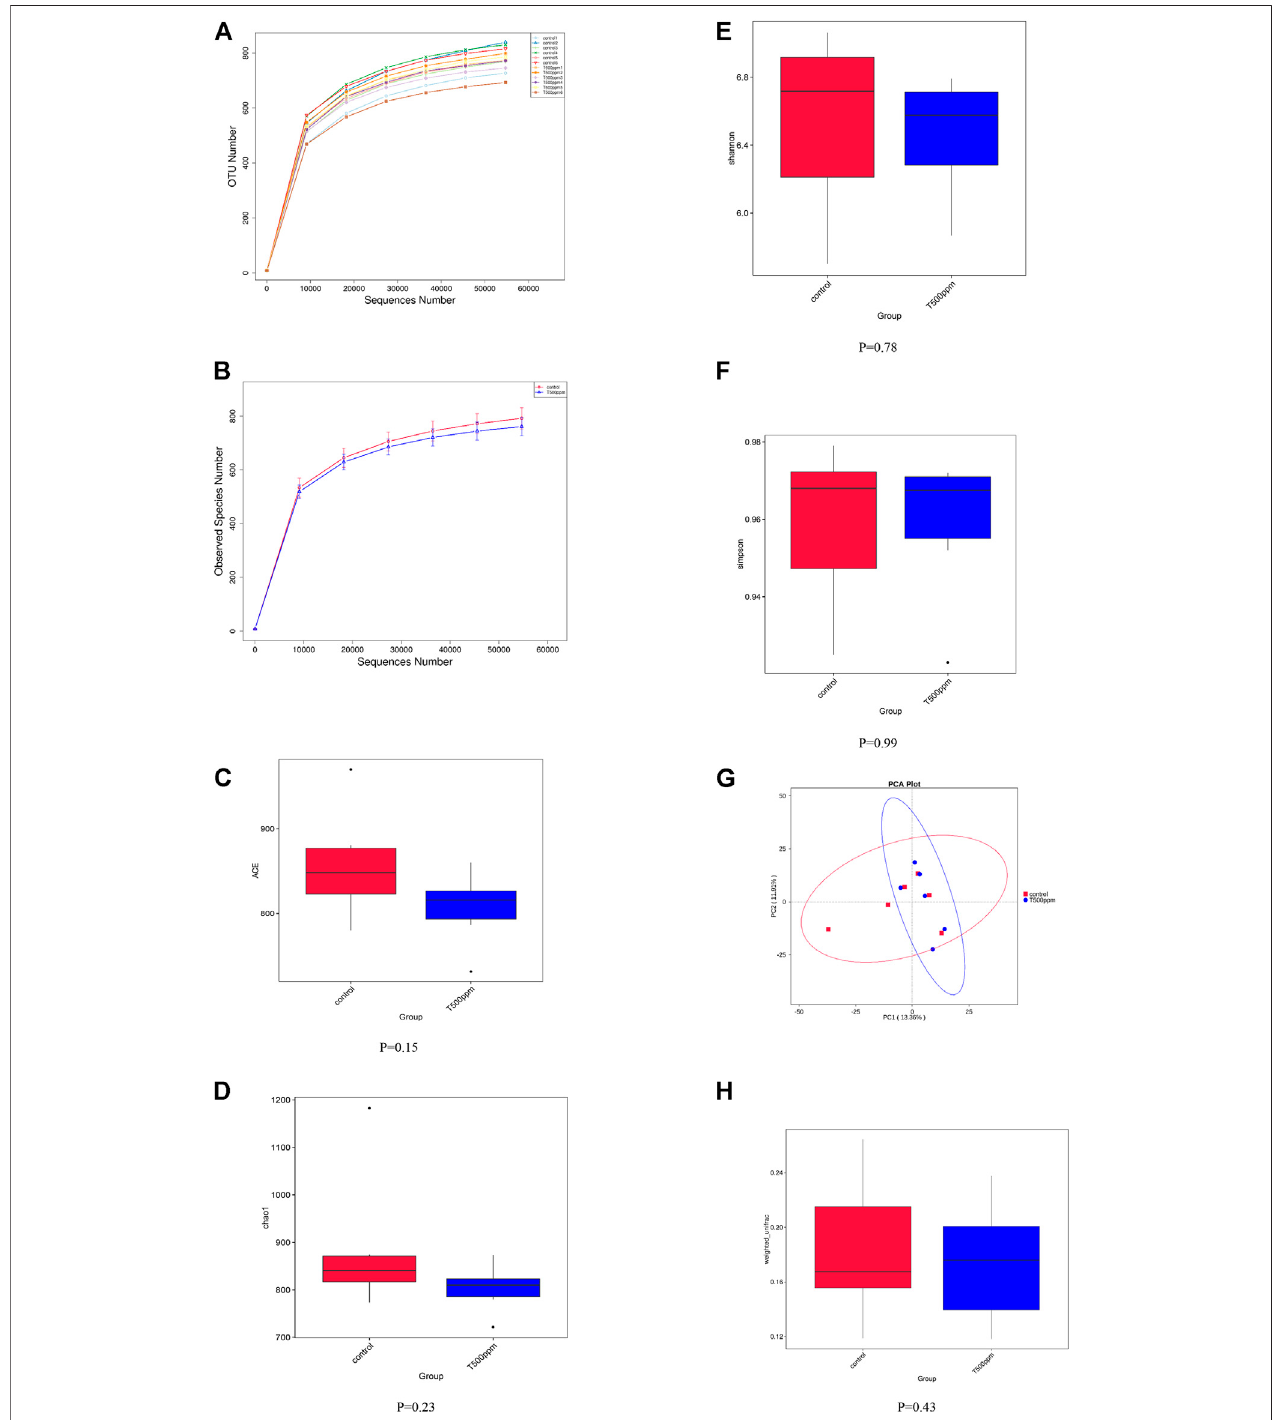
FIGURE 3 | (A,B) Rarefaction Curve. (C-F) Box graph of group differences by four alpha diversity indices. (G) Principal Component Analysis. (H) Box graph of β - diversity based on Weighted Unifrac.